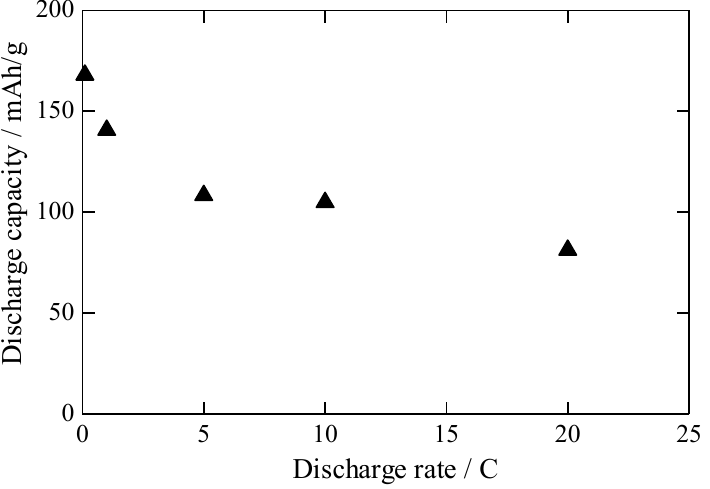
Figure 6. Relation between discharge rate and discharge capacity of RLTO anode material calcined at 1100  C under